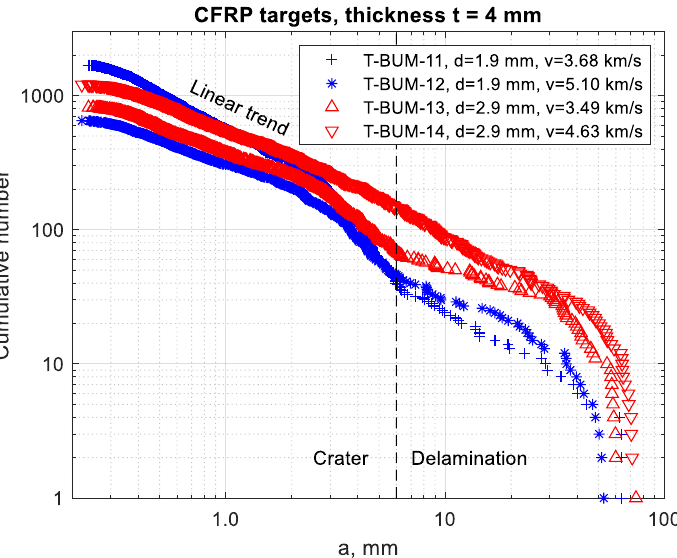
Figure 8. Fragment cumulative size distributions for the four CFRP thin plate tests.